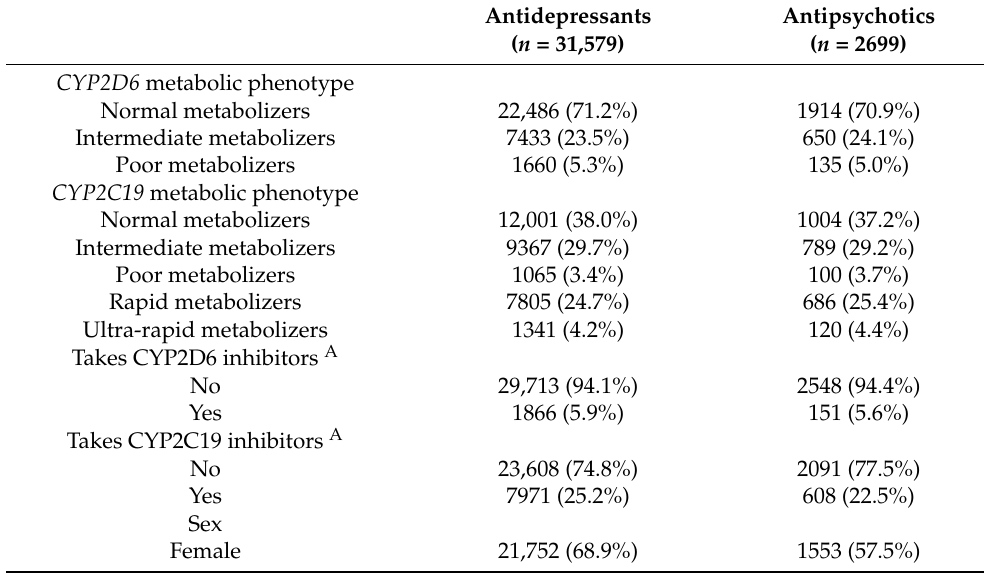
Table 1. Demographic Data for Study